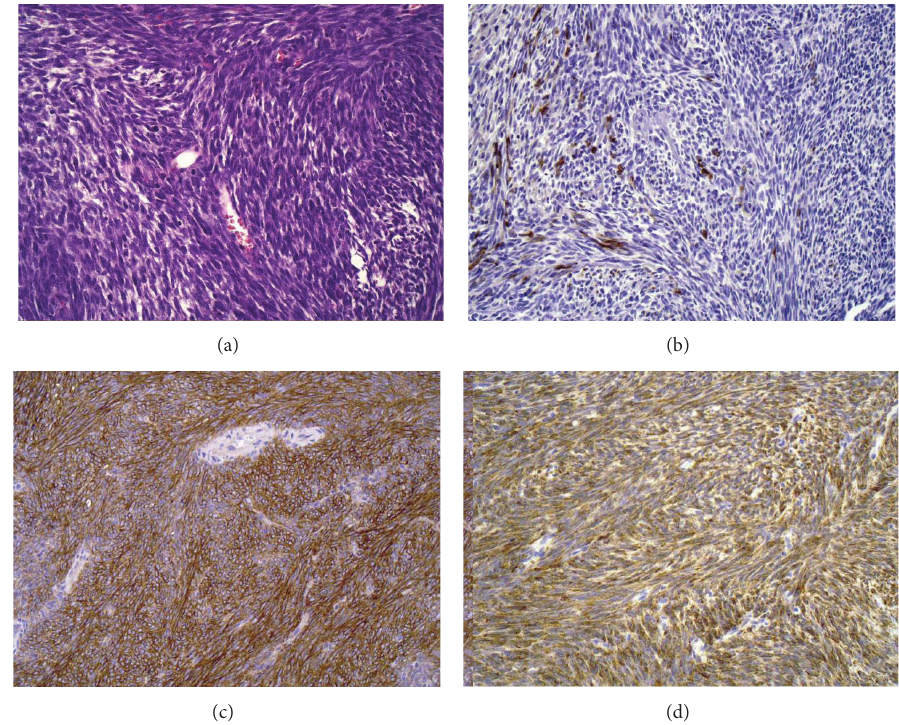
Figure 4: The spindle cells are small, uniform, and closely packed and have a high nuclear-cytoplasmic ratio (a). Immunohistochemical staining showing scattered spindle cells positive for CK AE1/AE3 (b). Diffuse expression of BCL-2 (c) and CD99 (d) in spindle cells.